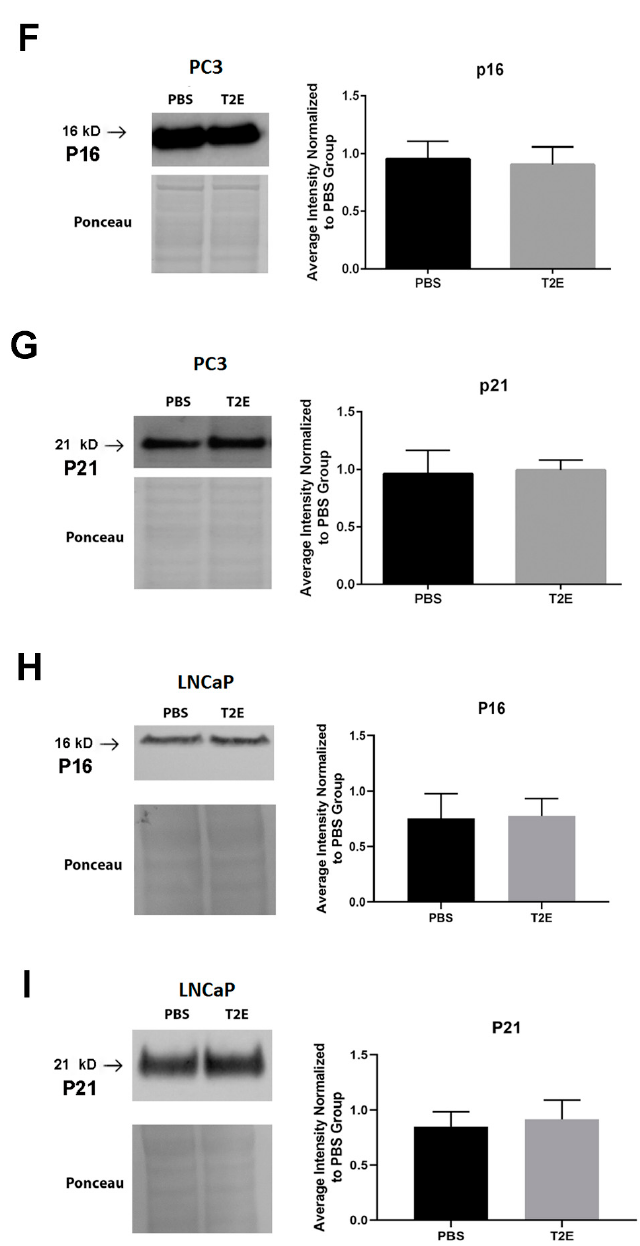
Figure 5. Phosphorylation levels and expression levels of PPP-regulated proteins. ( A ) Representative images of cyclin D1 and phospho-cyclin D1 (Thr 286) Western blots and ponceau staining in PC3 cells with densitometry of phosphorylation levels of cyclin D1. ( B ) Representative images of pRB and phospho-pRB (Ser-780) western blots and ponceau staining in PC3 cells with densitometry of phosphorylation levels of pRB. ( C ) Representative images of cyclin D1 and phospho-cyclin D1 (Thr 286) western blots and ponceau staining in LNCaP cells with densitometry of phosphorylation levels of cyclin D1. ( D ) Representative images of pRB and phospho-pRB (Ser-780) western blots and ponceau staining in LNCaP cells with densitometry of phosphorylation levels of pRB. ( E ) Representative images of pRB western blots and ponceau staining in both PC3 and LNCaP cells with densitometry of phosphorylation levels of pRB. ( F , G ) Representative images of western blots for p16 and p21 in PC3 cells, respectively, with densitometry analysis of p16 and p21. ( H , I ) Representative images of western blots for p16 and p21 in LNCaP cells, respectively, with densitometry analysis of p16 and p21. All data represent mean ± SD from at least three independent